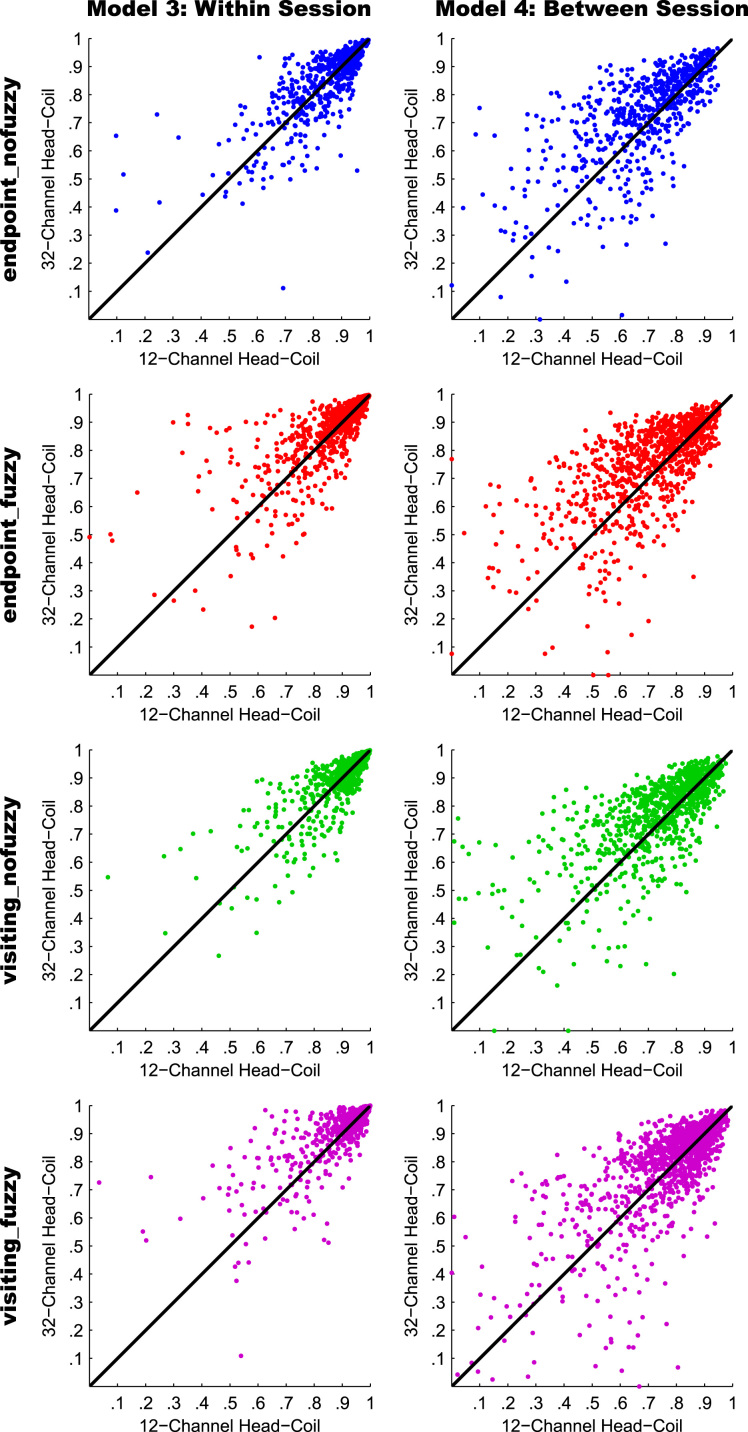
Scatterplots of connection-specific ICC(2,1) values for Models 3 (within-session reproducibility; left column) and 4 (between-session reproducibility; right column). In each column and for each streamline selection variant, the ICC(2,1) value for a given connection acquired with the 12-channel head-coil (x-axis) is plotted against the ICC(2,1) value for the same connection acquired with the 32-channel head-coil (y-axis). Thus, connections with a higher ICC(2,1) value for 32ch data are above the diagonal, and connections with a higher ICC(2,1) value for 12ch data are below the diagonal. For visualization purposes, negative ICC(2,1) values were set to zero (0.07% of values).